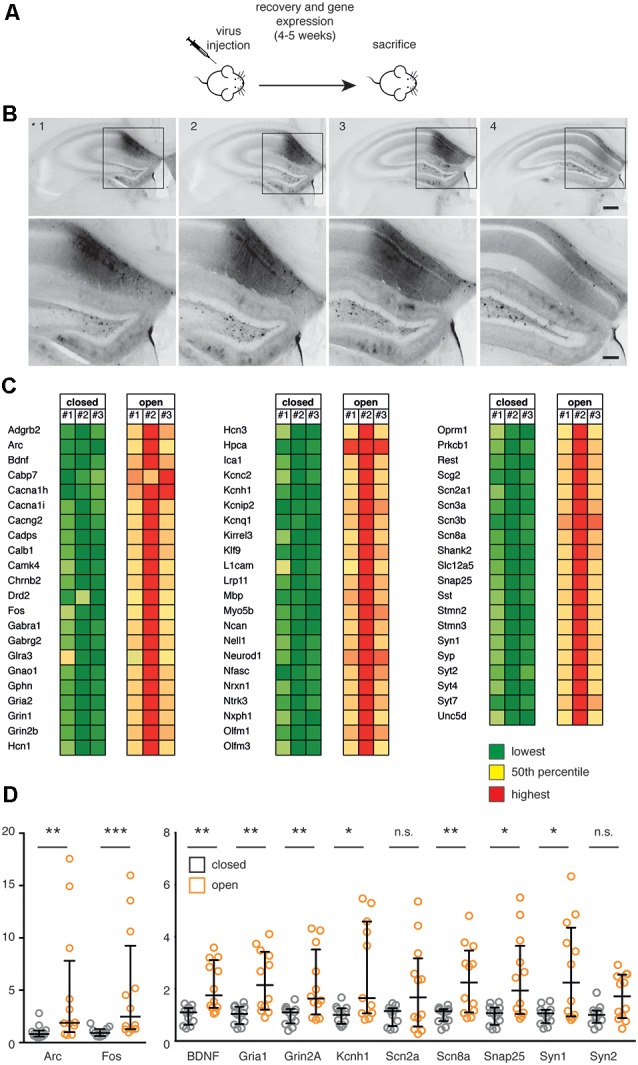
(A) Scheme of the in vivo experiment. C57Bl6/J male mice were subjected to stereotaxic injection within the hippocampus with recombinant AAV1/2 particles (0.65 μl-0.75 μl/hemisphere) expressing the constitutively closed [AsLOV2(C450A)-PAH1] or constitutively open [AsLOV2(I539E)-PAH1] probes, let recover for 4–5 weeks and sacrificed for gene expression studies. (B) Brain coronal slices (100 μm thickness) were prepared from paraformaldehyde (PFA)-fixed brain of AAV1/2-AsLOV2 injected mice (0.65 μl-0.75 μl/hemisphere), and transduced neurons in the hippocampus were detected by epifluorescence microscopy. Acquired images of four consecutive slices showed a high level of expression at the injection site, and a wide antero/posterior spread of the virus. Image 2 was taken at the injection site (from Bregma: AP 2.2, LAT 1.5; from brain: Z 1.65), the other images were acquired from slices at 100 μm intervals. Scale bars: 200 μm in low-magnification images, 100 μm in high-magnification images. (C) mRNA expression from the hippocampus of animals expressing either the constitutively open or the constitutively closed probe was analyzed using the Nanostring nCounter technology. We analyzed n = 3 animals per experimental group; a total of 64 REST-target (RE1-containing) genes were analyzed and the values were normalized against five housekeeping genes and for GFP expression. Results are color-coded separately within each gene: green color for low expression, red color for high expression. The complete list of genes and accession numbers is available in Supplementary Table S2;the expression values are available in Supplementary Table S3. (D) The expression of selected genes in the two experimental groups was validated by real time (RT)-PCR. Mann-Whitney test; n.s., non statistically significant (p > 0.05), *p < 0.05, **p < 0.01, ***p < 0.001; n = 12. Bars represent medians; whiskers represent interquartile ranges. The list of genes and accession numbers for RT-PCR is available in Supplementary Table S1.